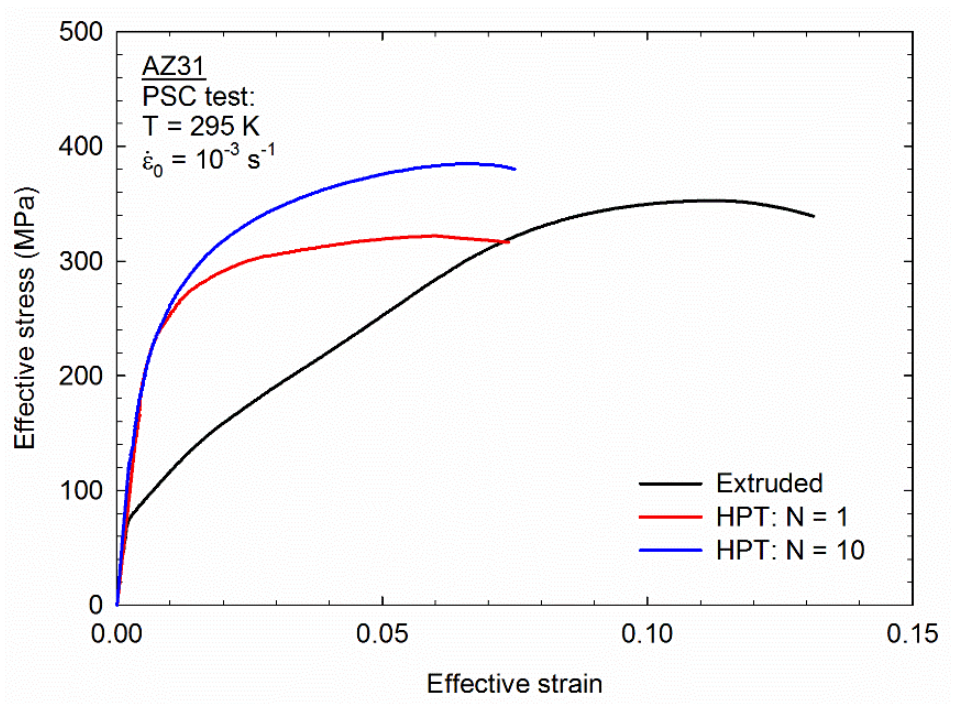
Figure 8. Stress vs. strain curves for AZ31 magnesium alloy with different processing conditions.